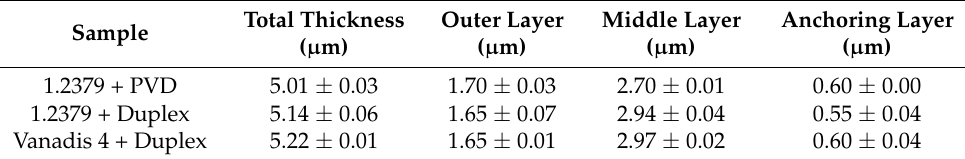
Figure 2. Calotest craters used to determine the resultant thickness for the 1.2379 + PVD sample ( a ), 1.2379 + Duplex sample ( b ), and Vanadis 4 + Duplex sample ( c ). The different circumferences correspond to the different rings exposed after the abrasion of the coating with the balls used for the calculation of each thickness value.